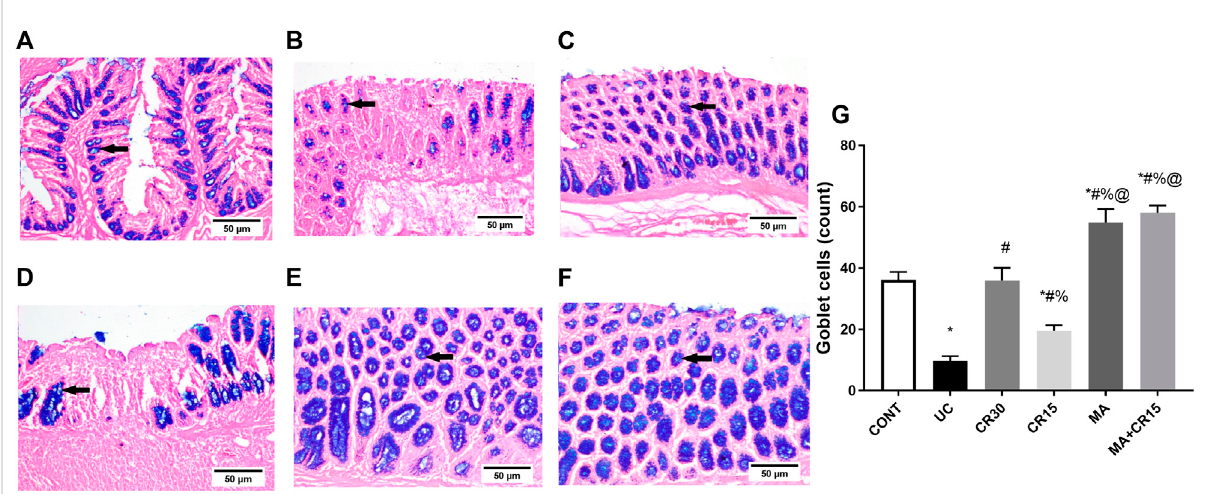
FIGURE 5 Effect ofmirabegron and/or carvedilol on the number of goblet cells in the colon of rats with IAA-inducedulcerative colitis. Data are presented as mean ± SD (n = 3). Statistical analysis was carried out using one-way ANOVA followed by Tukey ’ s posthoc test; p < 0.05, as compared to the (*) CONT,(#)UC,(%)CR30,and(@)CR15groups.Panels (A – F) representcolonphotomicrographsstainedwithAlcianblue(scalebar,50 μ m).Sectionof (B) IAAmodelshowsasharpdecreaseinthenumberofGCs,comparedtothatof (A) CONTgroup.Sectionoftheulcerated ratstreatedwith (D) CR15 shows an increase in GCs, whereas that of the (C) CR30 treated group reaches a normal level. However, treatment with (E) MA and (F) MA+CR15 showsamarkedincrease inthenumberofGCs thatexceededthatinpanel (A) (arrows).Panel (G) summarizestheaboveresults (5 fi eldsin each section). CONT, control; CR, carvedilol; IAA, iodoacetamide; MA, mirabegron; UC, ulcerative